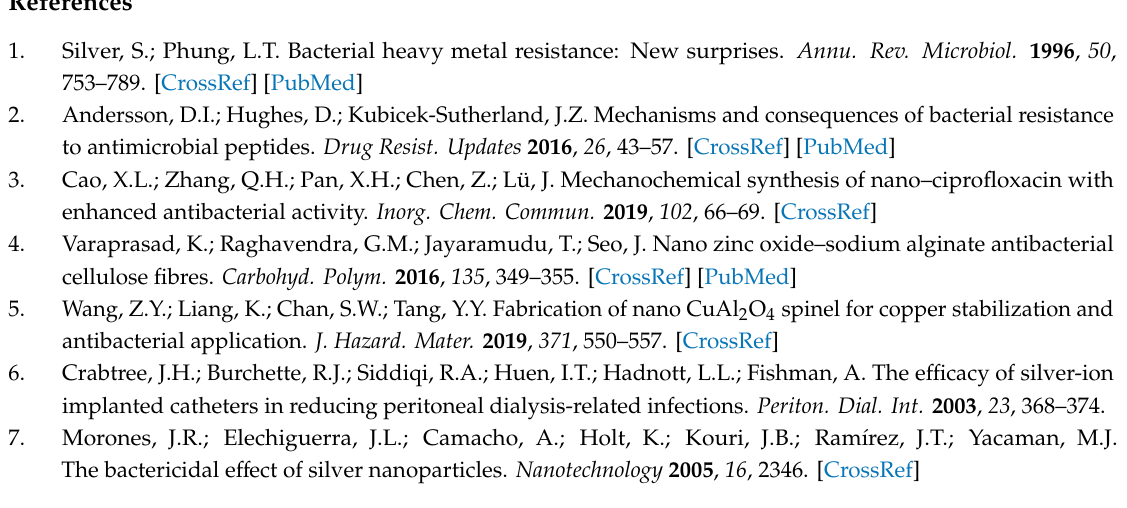
Figure 10. Bacterial growth curves in LB medium supplemented with different concentrations of Fe 3 O 4 @PDA / Ag / PDA nanospheres: Staphylococcus aureus ( a ) and Escherichia coli ( b